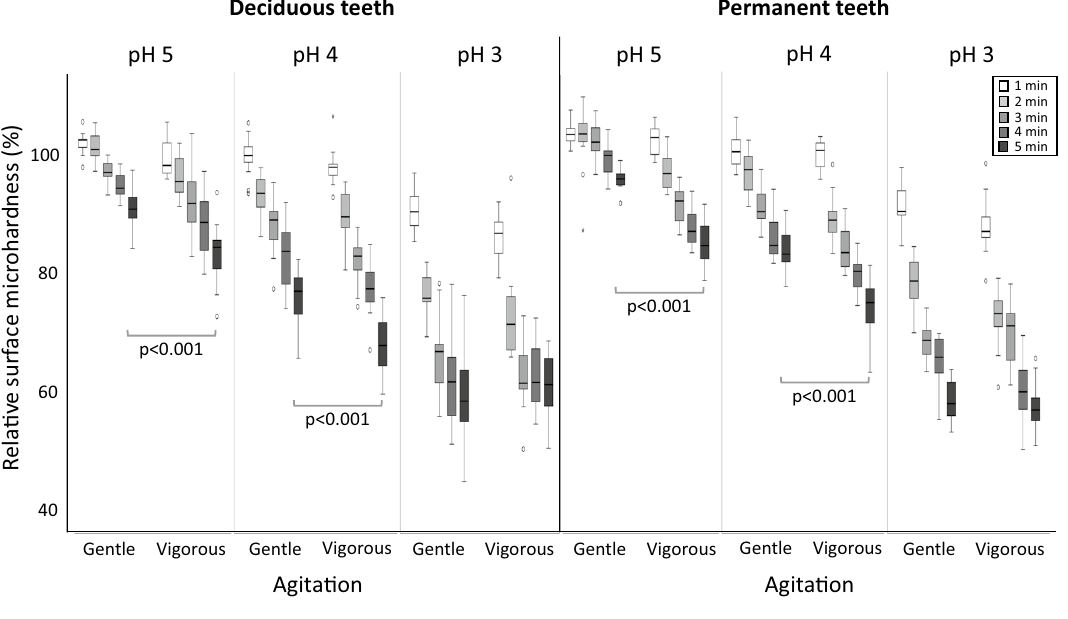
Figure 1. Box-plots for the relative surface microhardness (rSMH, %) of deciduous and permanent teeth, according to the incubation time in citric acid (1 min to 5 min, different shaded boxes), the pH of the citric acid (pH 5, pH 4 or pH 3), and the agitation (gentle or vigorous shaking). Significant differences between gentle and vigorous shaking after 5 min incubation are shown when p <